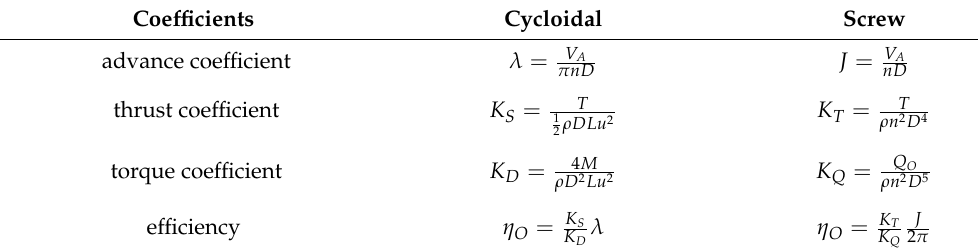
J = V A nD π nD 1 2 2 ρ DLu